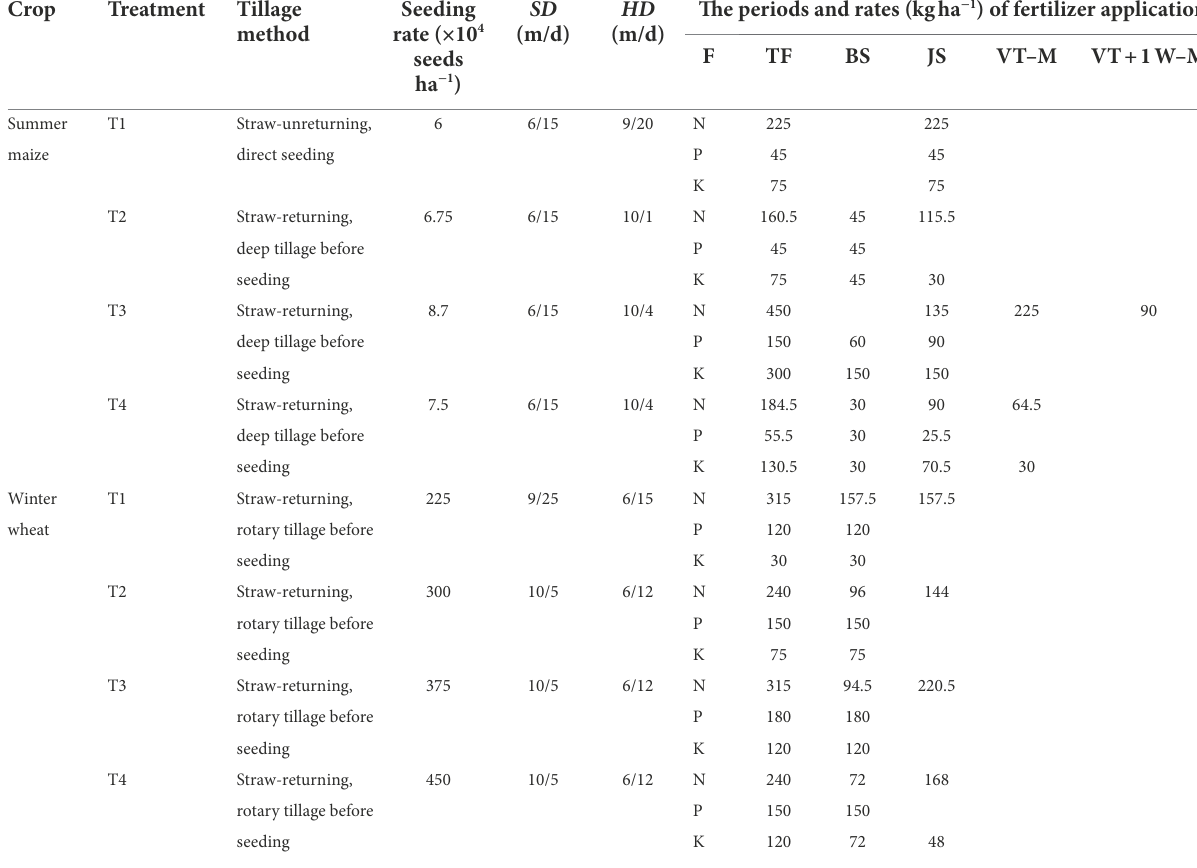
TABLE 1 Cultivation management and fertilizer strategies of different integrated soil-crop managements.